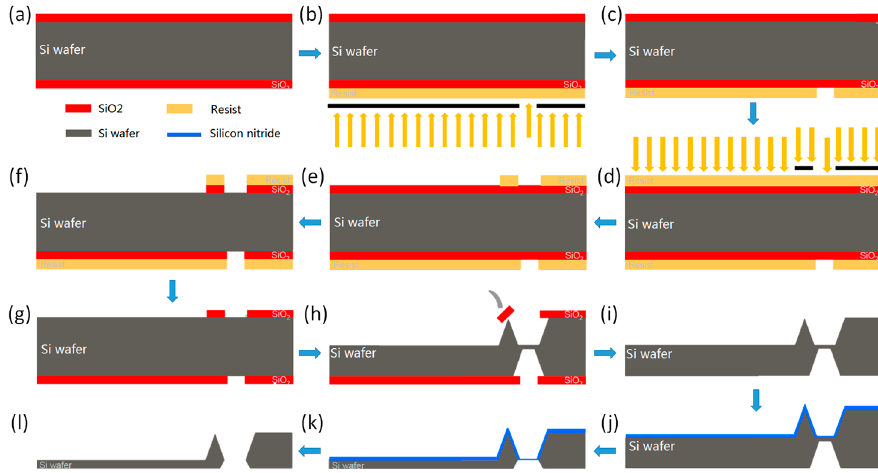
Figure 6. Schematic illustration of standard AFM probes manufacturing by Nanoworld. ( a ) Silicon wafer with both sides of silicon dioxides; ( b,d ) exposure of the back and front sides to photoresist through a mask; ( c,e ) development of the exposed photoresist; ( f ) isotropic wet etching of silicon oxide; ( g ) dissolution of photo resist; ( h,i ) anisotropic wet etching of silicon by KOH and silicon oxide; ( j–l ) deposition and isotropic wet etching of silicon and silicon nitride, respectively. Reproduced with permission from [38], copyright Nanoworld 2008.